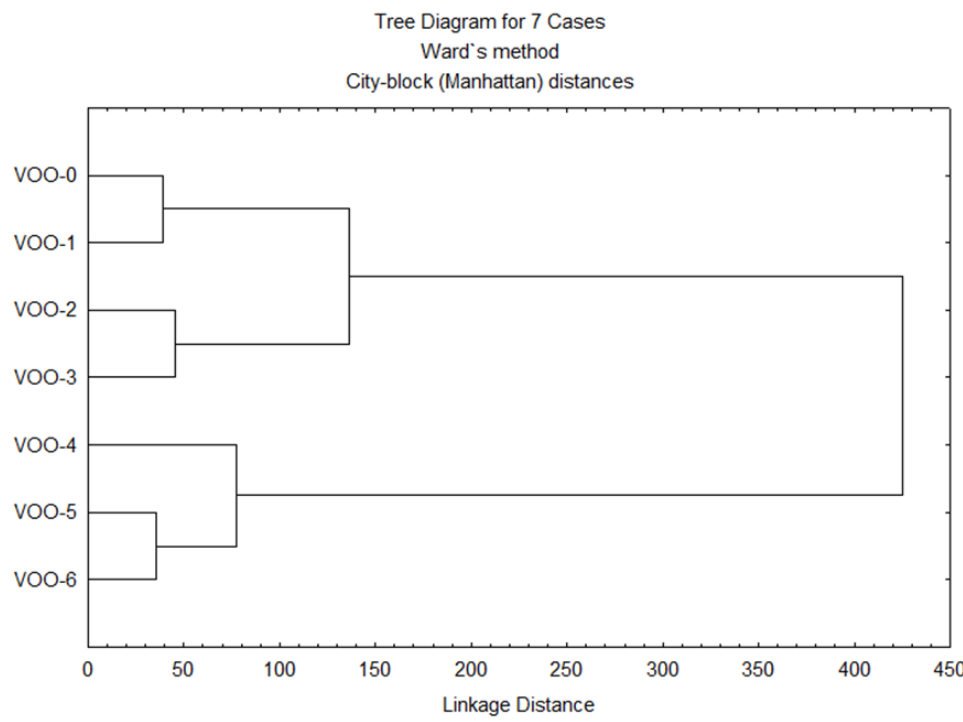
Figure 2. Cluster analysis of the volatile compounds of the VOO samples.